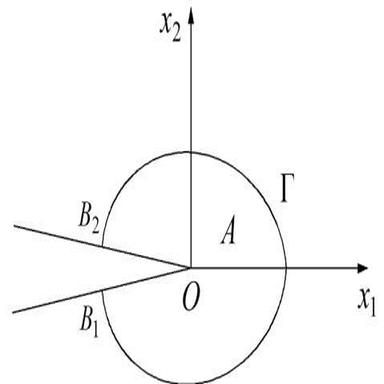
The schematic of a contour Γ and the area A enclosed by Γ around the crack tip.